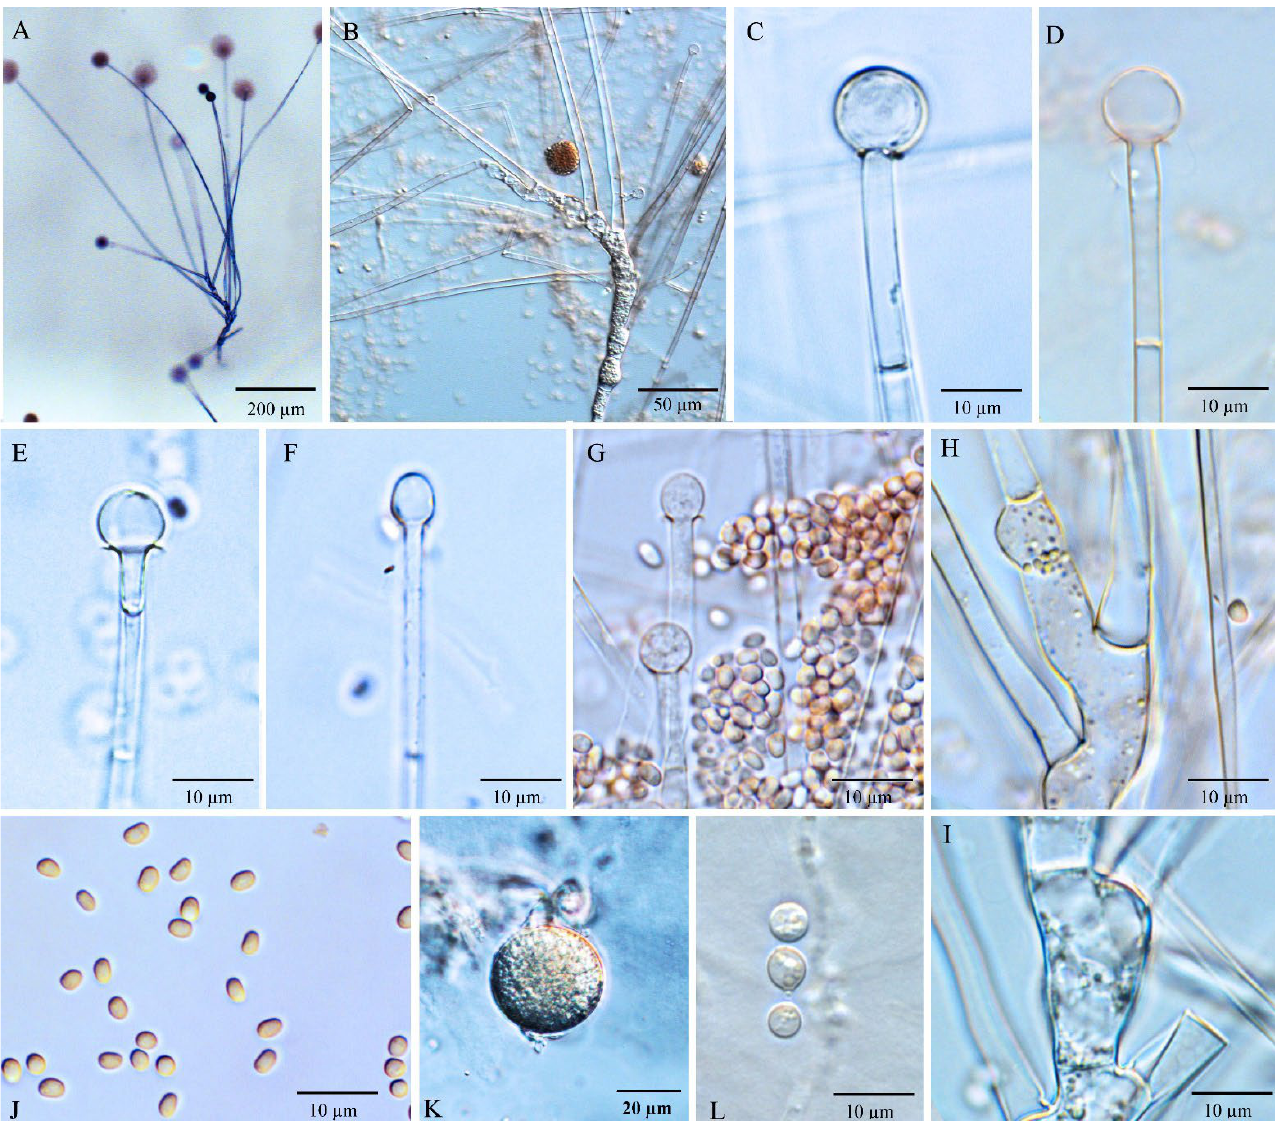
Figure 7. Umbelopsis ramanniana . ( A , B ) Branched sporangiophores. ( C – G ) Various shapes of collars and columellae at sporangiophore tips after the sporangia have been dissolved. ( H , I ) Branch point of sporangiophore. ( J ) Sporangiospores. ( K ) Macro-chlamydospores. ( L ) Micro-chlamydospores. Maximum growth temperature: 33–35 (–36) ◦